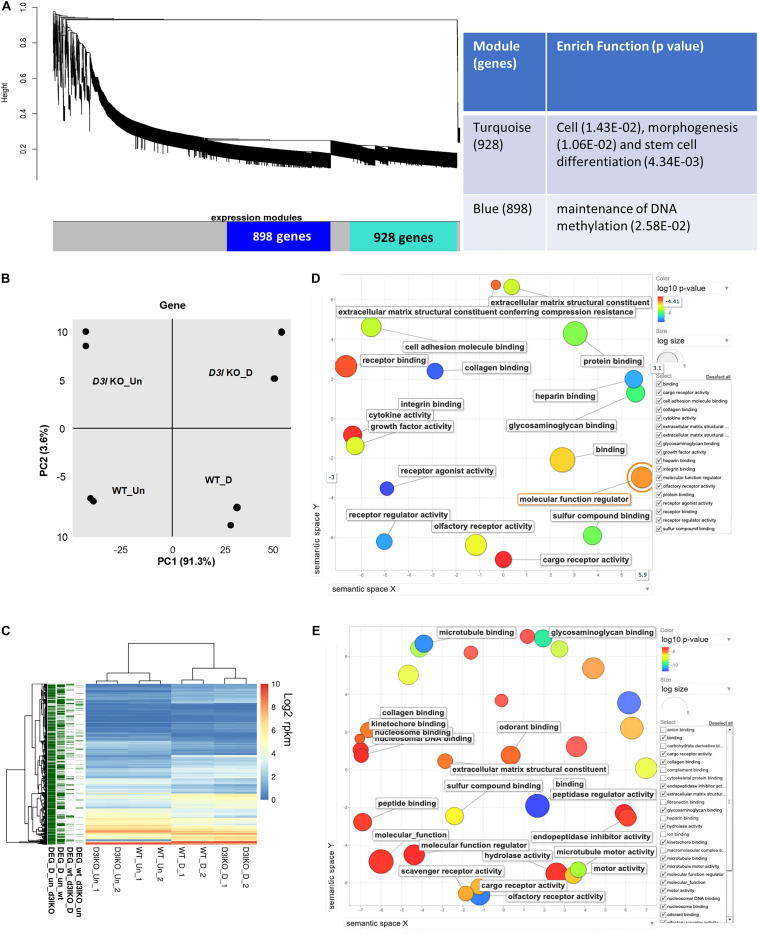
Analyses of Dnmt3l genotype-specific differentially expressed genes (DEGs) in undifferentiated and differentiating MSCs on day 3 of osteogenic induction. (A) Weighted correlation network analysis was performed, with the two major gene modules marked in turquoise and blue. The first (turquoise block) module contains 928 genes enriched in cell, morphogenesis and stem cell differentiation. The other module has 898 genes that are categorized as maintenance of DNA methylation. (B) Principal component analysis (PCA) of gene expression. (C) Each row represents a DEG. Four groups of DEGs are shown on the left and marked in green. Most DEGs highlight the transition during differentiation. There are also differences between the WT and Dnmt3l KO MSCs, indicating the contribution of DNMT3L to these differences. The heatmaps illustrate the expression patterns of genes that are modulated by either differentiation or the DNMT3L effect. DEG_wt_d3l_un: DEGs between WT and Dnmt3l KO in undifferentiated MSCs; DEG_wt_d3lKO_D: DEGs between WT and Dnmt3l KO in differentiating MSCs; DEG_D_un_wt: DEGs between undifferentiated and differentiating MSCs derived from WT mice; and DEG_D_un_d3lKO: DEGs between undifferentiated and differentiating MSCs in Dnmt3l KO mice-derived MSCs. (D) Gene ontology analysis of DEGs between WT and Dnmt3l KO undifferentiated MSCs. (E) Gene ontology analysis of osteogenic differentiating (day 3 of osteogenic induction) DEGs between WT and Dnmt3l KO MSCs. All GO terms presented on the bubble plots have an adjusted p-value of <0.05.